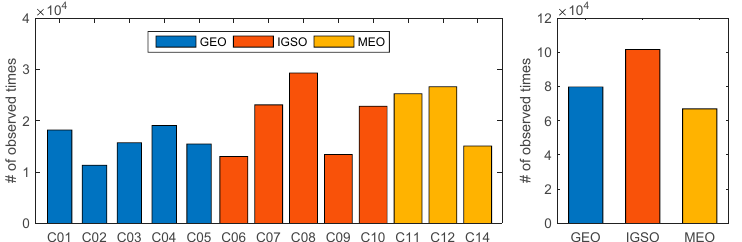
Figure 5. Total number of observed times at 30 s interval for BeiDou satellites and types during July 2017, left subgraph represents for each BeiDou satellite and right subgraph represents for GEO, IGSO, and MEO, respectively.